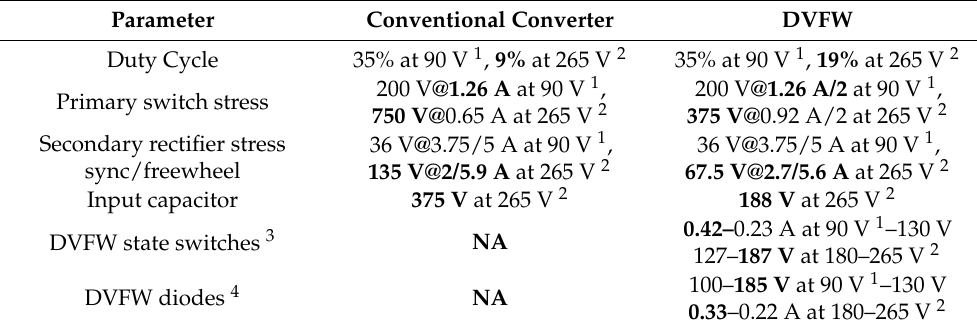
Table 2. Parameters comparison between conventional forward converter and DVFW.